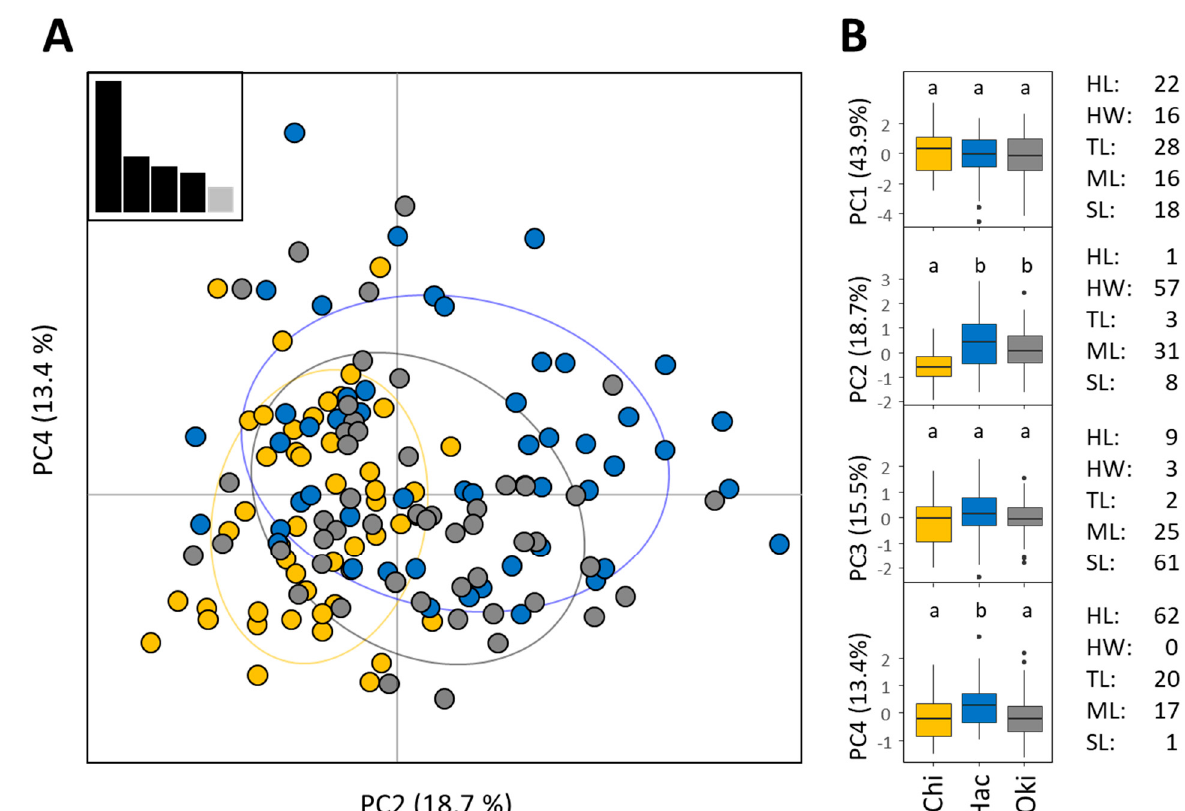
Figure 6. ( A ) PCA analysis based on five morphological characters of T . brunneus from three island populations. The PC axes 2 and 4 are shown as only these exhibited significant differences between populations. Yellow circles indicate ants from Chichijima, blue from Hachijojima and grey, Okinawa. Inset: plot of eigenvalues of PC axes. ( B ) Boxplots of four main PC axes and percentage contribution of each morphological character to that PC axis. Characters were HW (Head Width), HL (Head Length), TL (Tibia Length), ML (Mesosoma Length), and SL (Scape Length). In the boxplot figure, boxes represent quartiles, the horizontal bar indicates the median, whiskers represent the minimum and maximum values, and points indicate outliers. Letters above boxes show groups indicated by Dunn’s test. Chi = Chichijima, Hac = Hachijojima, and Oki = Okinawa.